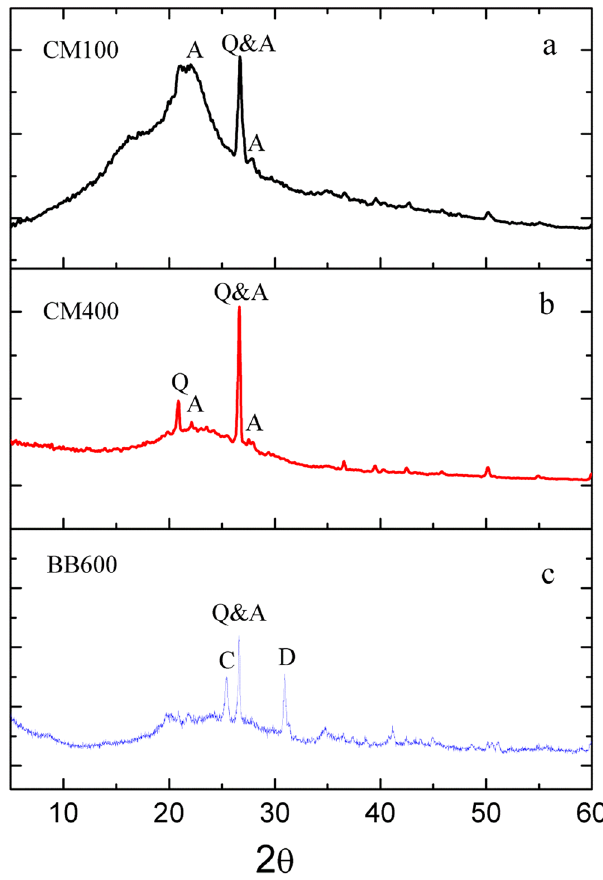
Figure 3. X-ray diffraction patterns of the cattle manure biochar (CM100 and CM400), Bamboo biochar (BB600). The numbers in the sample names represent the pyrolysis temperatures. The following minerals are labeled with respect to their peaks: A, albite; C, calcium sulfate; D, dolomite and Q, quartz.